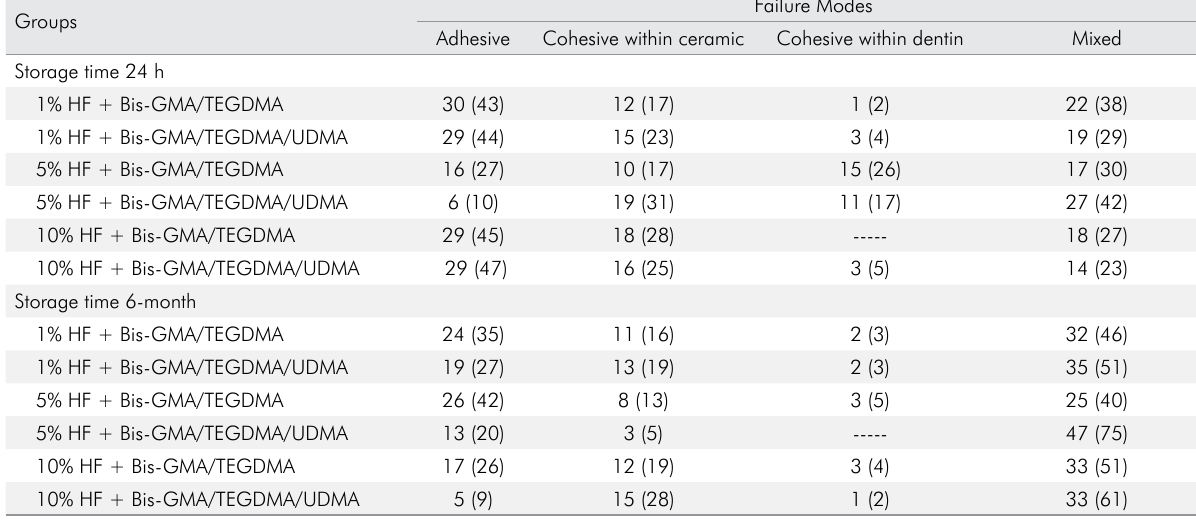
Table 3. Failure Modes Analysis (total number followed by % in parentheses) of the debonded specimens among groups.